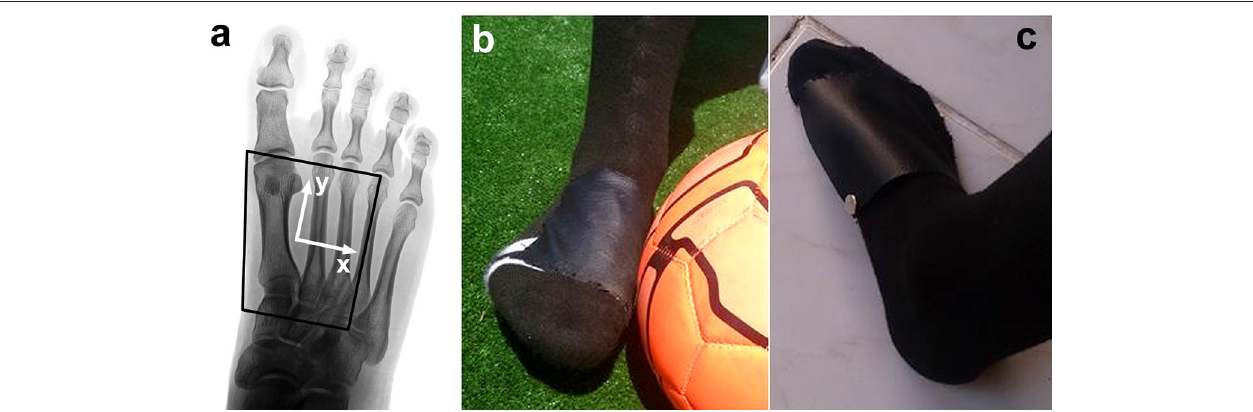
FIGURE 3 | Schematic experimental set-up for the curved kick; players had to kick a left-curved kick around an artificial wall (red) inside the target (green); the dashed line represents the trajectory of the ball; the dotted line highlights that a straight shot will not deliver a successful kick.